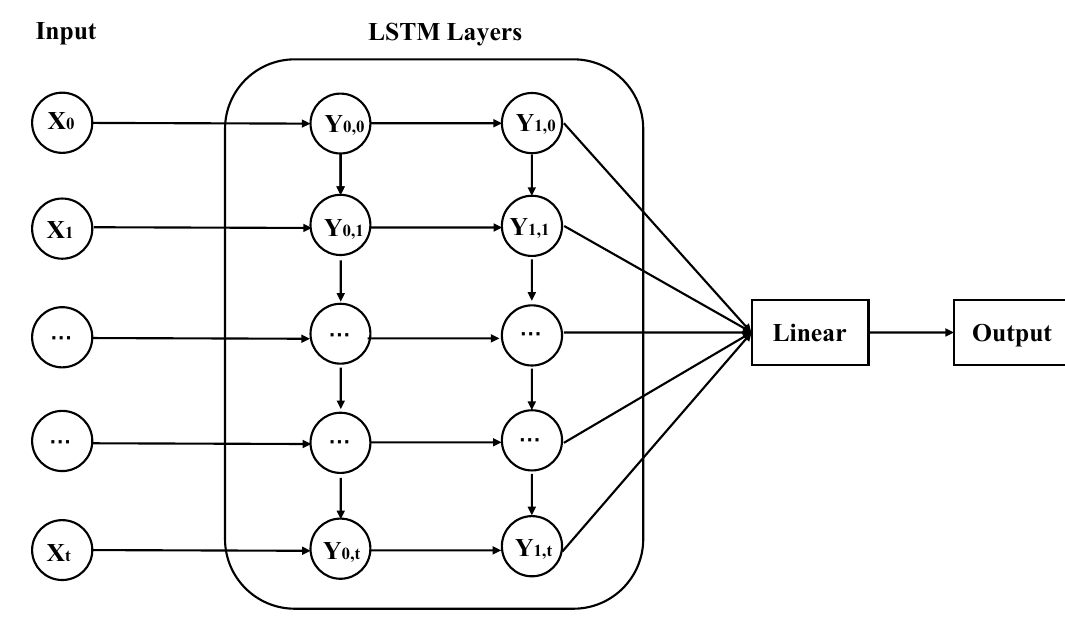
Figure 4. The schematic diagram of DSDnet network.